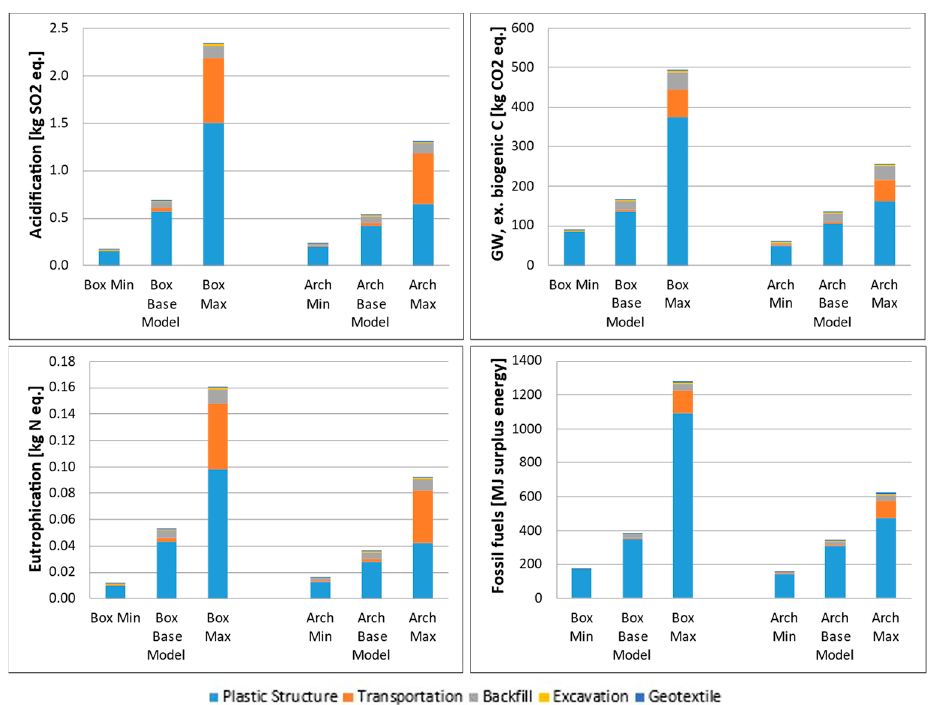
Figure 3. Traci 2.1 midpoint impact ranges for box and arch structures per cubic meter of stormwater management show that box structures generally have larger potential midpoint impact than arch structures and that the variability of the plastic structure is significant for both box and arch. The transportation upside strongly hinges on the 300 km (max) transport distance for the backfill material. At 30 km (min) transport distances, the transport of all materials in the inventory is small and comparable to the magnitude of the backfill material, excavation, and geotextile. (Data in Supplementary Materials Table SI-4).